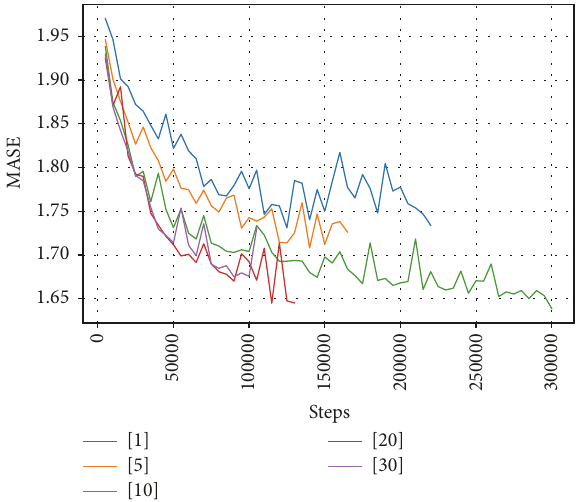
Figure 14: Trend in sensitivity for different disturbances in the wind